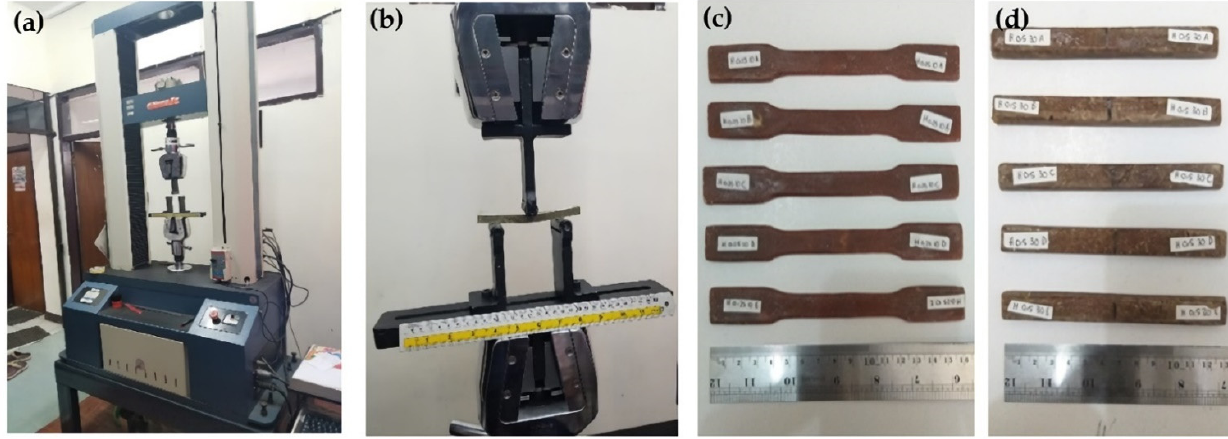
Figure 3. Preparation: ( a ) tensile test machine; ( b ) flexural test machine; ( c ) tensile test specimen; ( d ) flexural test specimen.